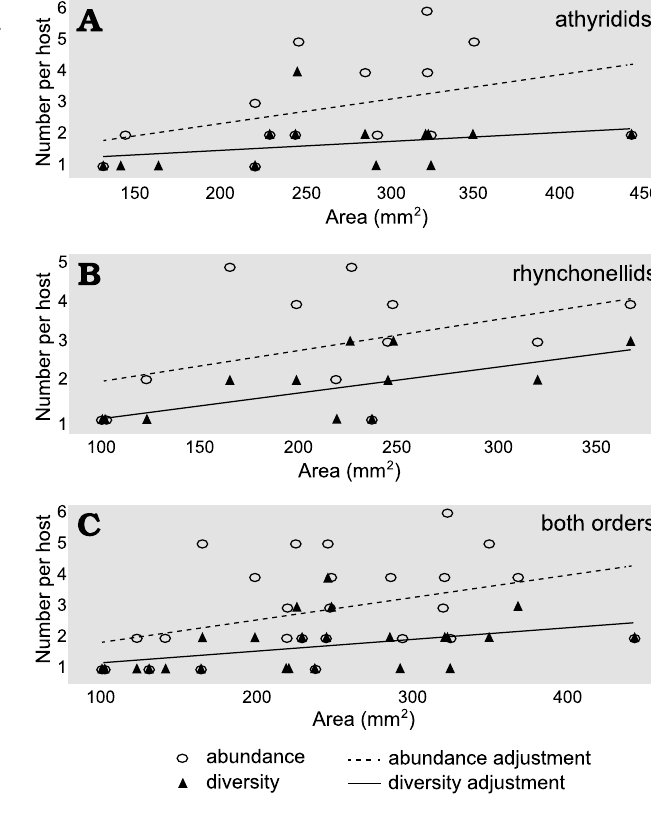
Fig. 7. Diversity and abundance of sclerobionts versus potential area of bra- chiopods brachiopods: athyridids ( A ), rhynchonellids ( B ), and both orders ( C ). The adjustments allowed us to observe low to moderate correlation in all